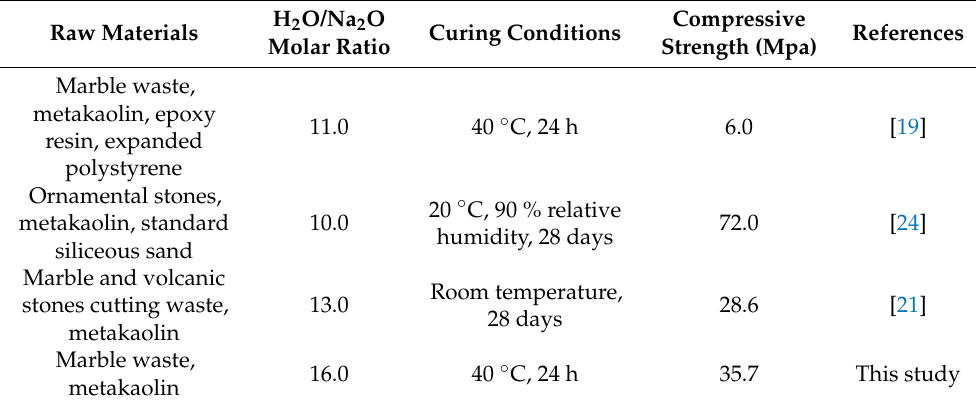
Table 5. Comparison of synthesis conditions and compressive strength values for ornamental stone industry waste and metakaolin-based AAMs.